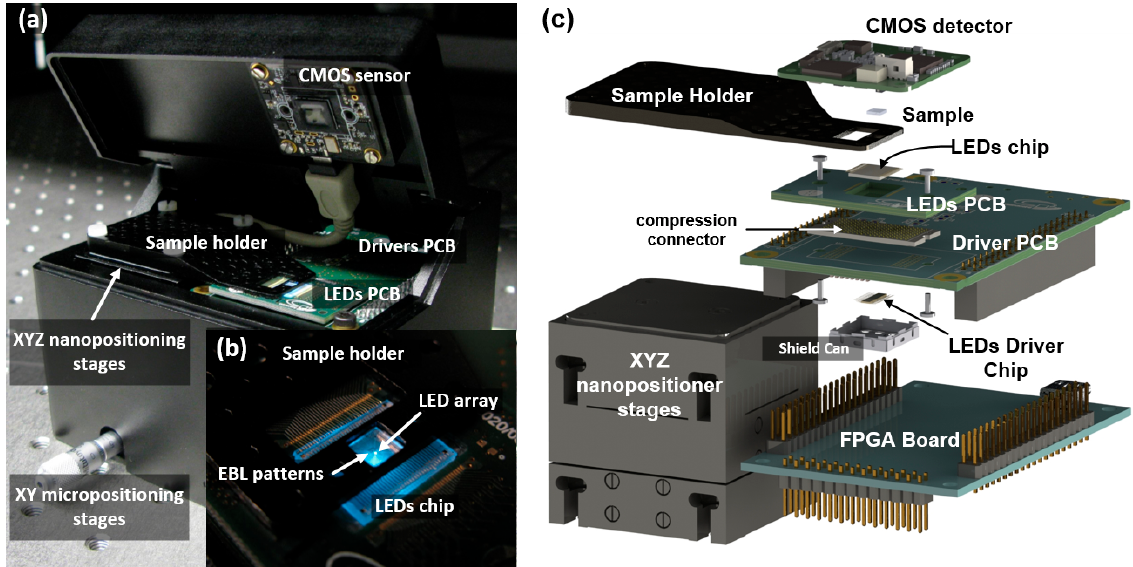
Figure 9. ( a ) Image of the microscope configuration with nanopositioner stages to extend the FOV, and ( b ) a detail of the sample over the LED array. ( c ) Exploded view of the second generation microscope stack-up structure with nano-stages.